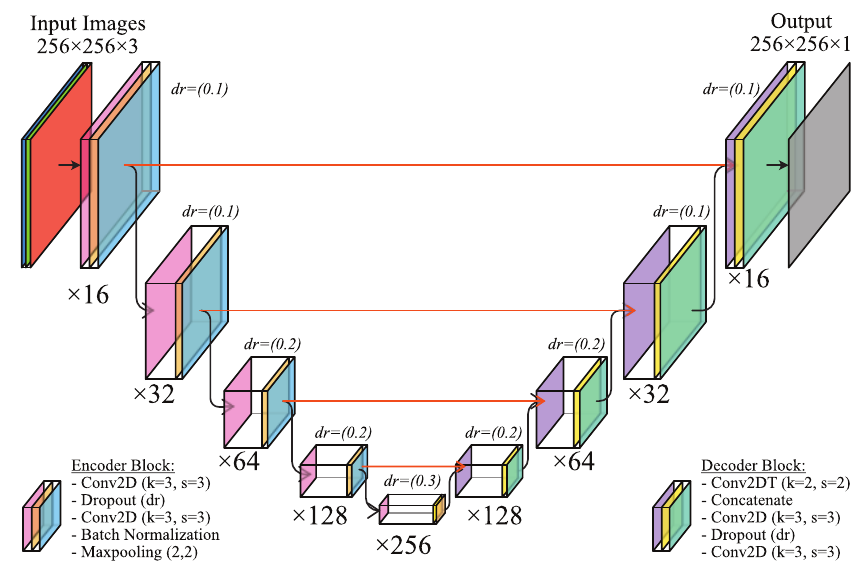
Figure 4. SpecSeg configuration based on the U-net